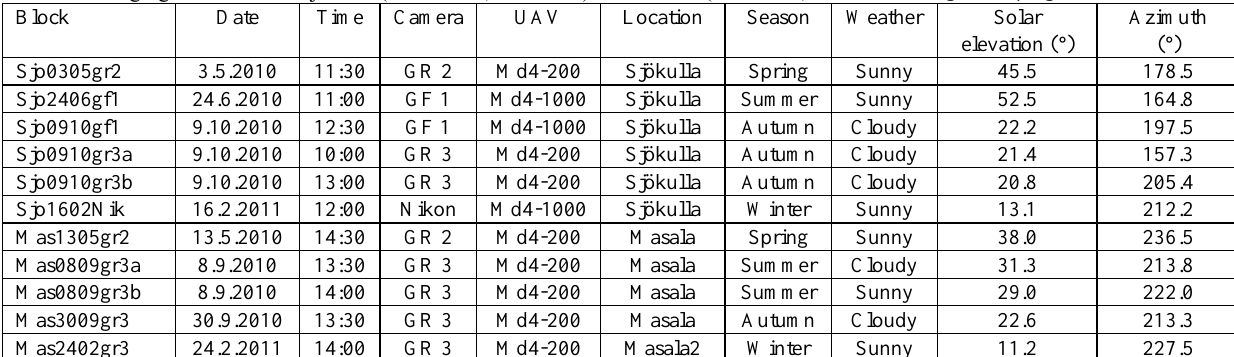
Table 2. Imaging conditions in Sjökulla (60º14’31’’, 24º23’1’’) and Masala (60°9’39’’, 24°32’41’’) flight campaigns. Block